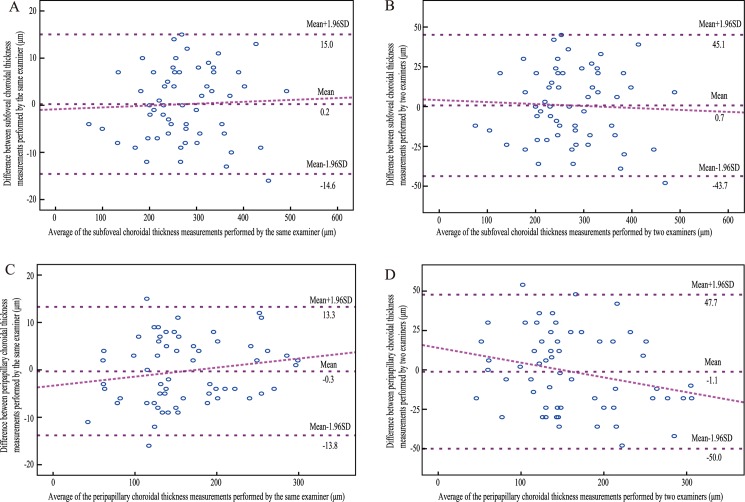
Bland-Altman plots of intraobserver and interobserver reproducibilities.(A) subfoveal choroidal thickness measurements performed by the same examiner (B) subfoveal choroidal thickness measurements performed by two examiners (C) peripapillary choroidal thickness measurement performed by the same examiner (D) peripapillary choroidal thickness measurements performed by two examiners.